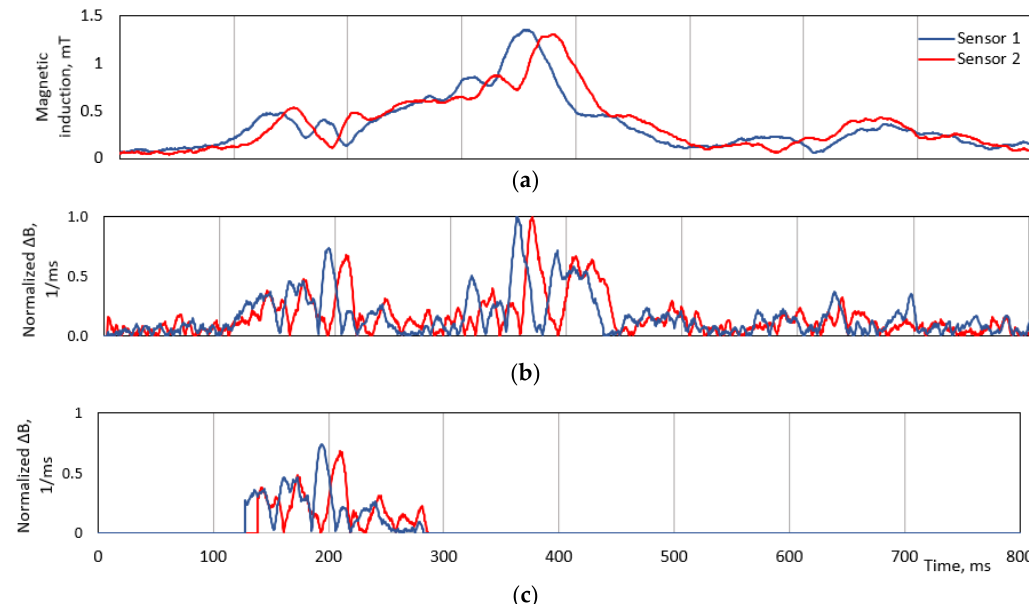
Figure 5. An example of signals cropping algorithm with the windows method. ( a ) An original magnetic field magnitude. ( b ) The normalized module of derivative of magnitude. ( c ) The result of the signature cropping algorithm—a pair of fractions of derivative signals.